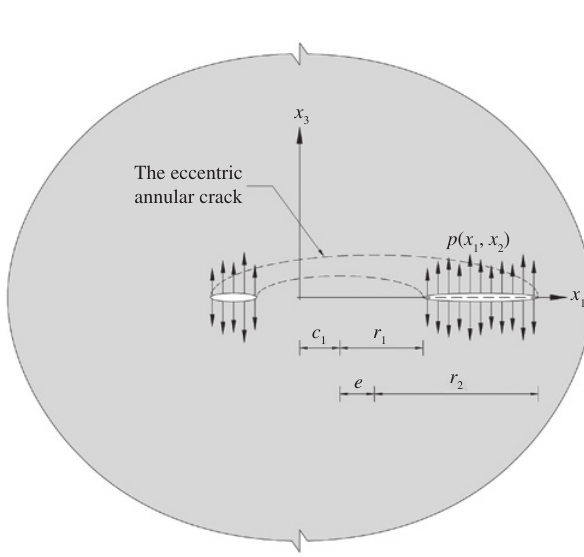
Figure 1: The geometry of the eccentric annular